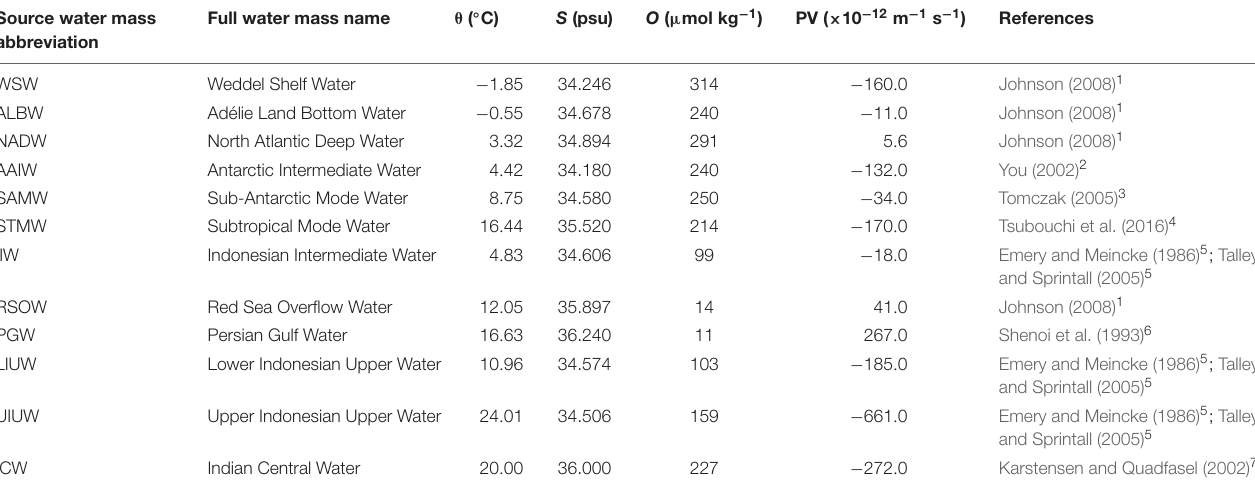
TABLE 1 | Seawater properties of the source water